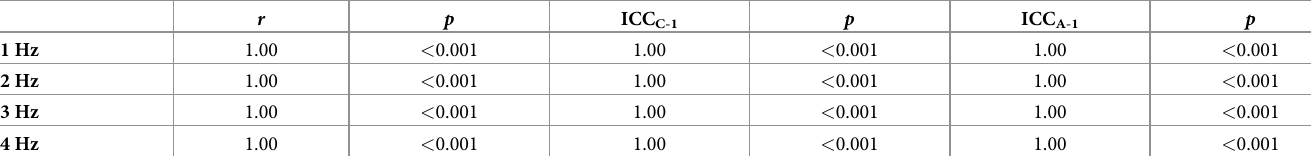
Table 3. Statistical results for correlational analyses of pose estimation vs. manual identification of hand pronation/supination.